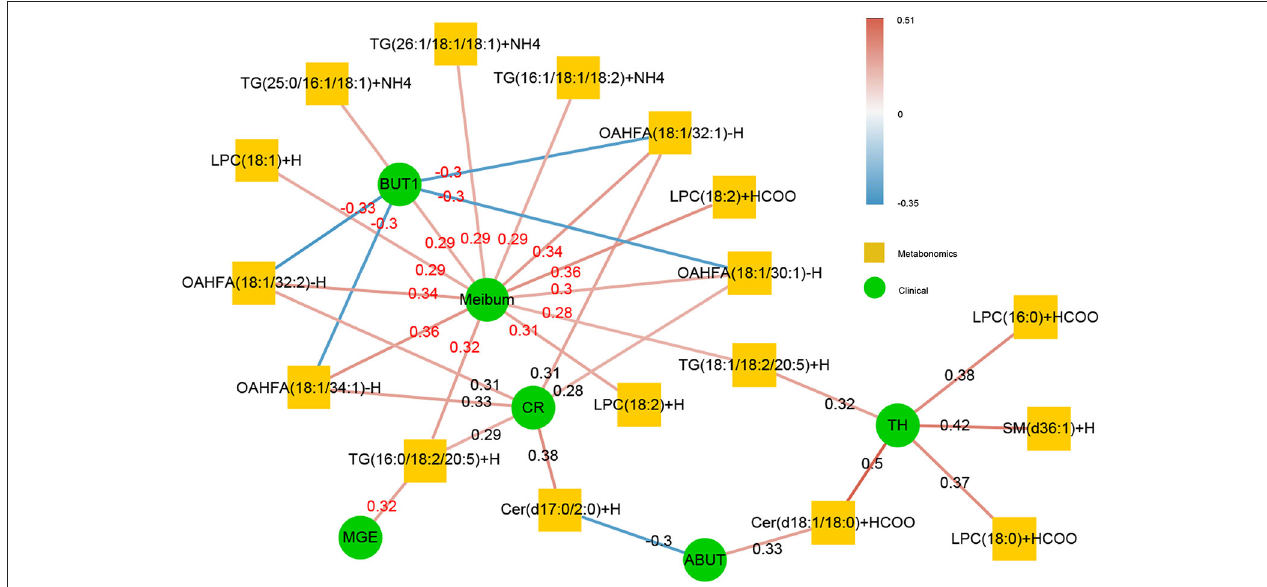
FIGURE 5 | The correlation of significant subclasses of lipids with the clinical syndrome. The change in the lipid metabolic was highly related to the improvement in the clinical index. The correlation was rich in TBUT, CR, and meibum quality, and some lipids were crossrelated to them. The green in the middle represents the clinical index data, and the orange in the outer circle is the differential metabolic lipid. The darker the color of the line was, the stronger the correlation was, and the number on the line was the r -value of its correlation coefficient. The red line indicated that there was a positive correlation between the two, whereas the blue line represented a negative correlation between the